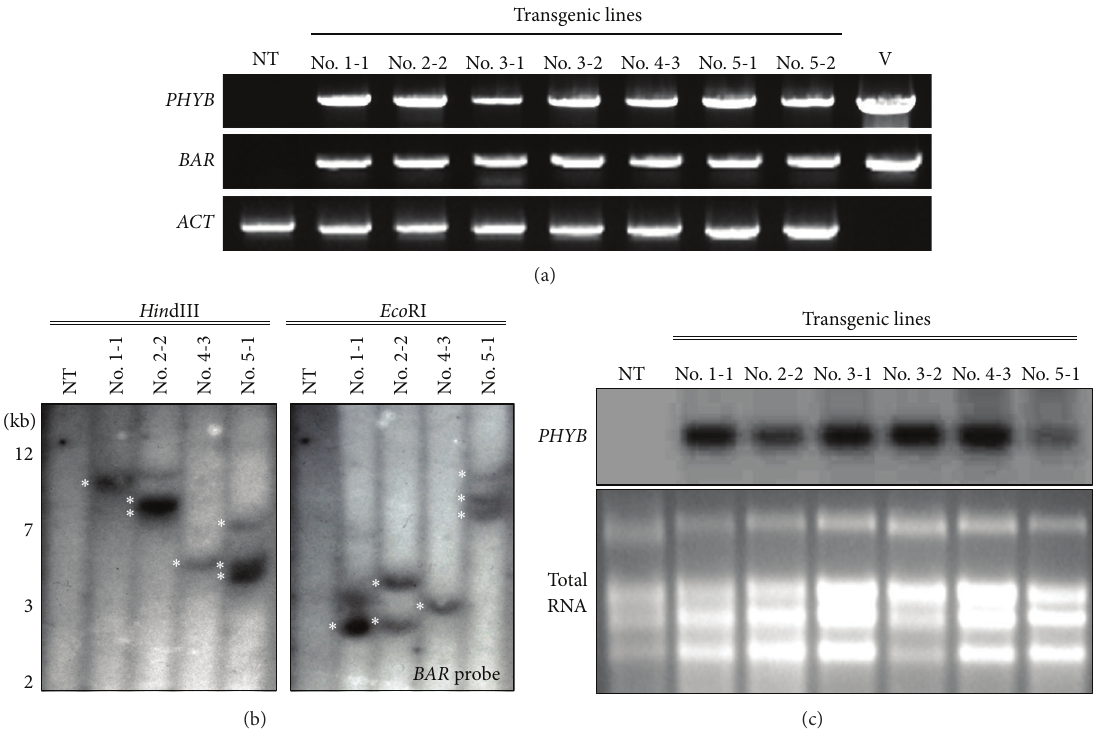
Figure 3: Molecular analyses of representative transgenic Miscanthus plants with PHYB . (a) Genomic PCR analysis of transgenic lines. The coding regions of the PHYB and BAR transgenes were amplified by PCR from genomic DNA. The actin gene ( ACT ) of M. sinensis plants was shown as a loading control of the genomic DNA. NT: nontransformed control plant; V: pCAMBIA3301 harboring PHYB gene that was used for transformation. (b) Southern blot analysis of transgenic lines. Genomic DNA (15 𝜇 g) from each transgenic plant was digested with either Hin dIII or Eco RI and then probed with the BAR gene. Numbers in lanes represent independent transgenic lines selected for analysis, and asterisks indicate the BAR bands. (c) Northern blot analysis of transgenic lines. Total RNA was isolated from the leaves of transgenic plants and the PHYB gene was used as a probe. Total RNA was shown as a loading control.